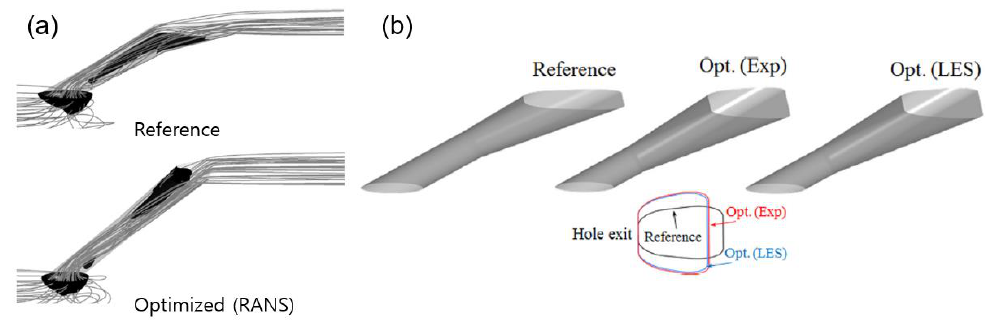
Figure 8. Shape optimization of fan-shaped holes: ( a ) RANS-based optimization [117] and ( b ) experiment- and LES-based optimizations [79].